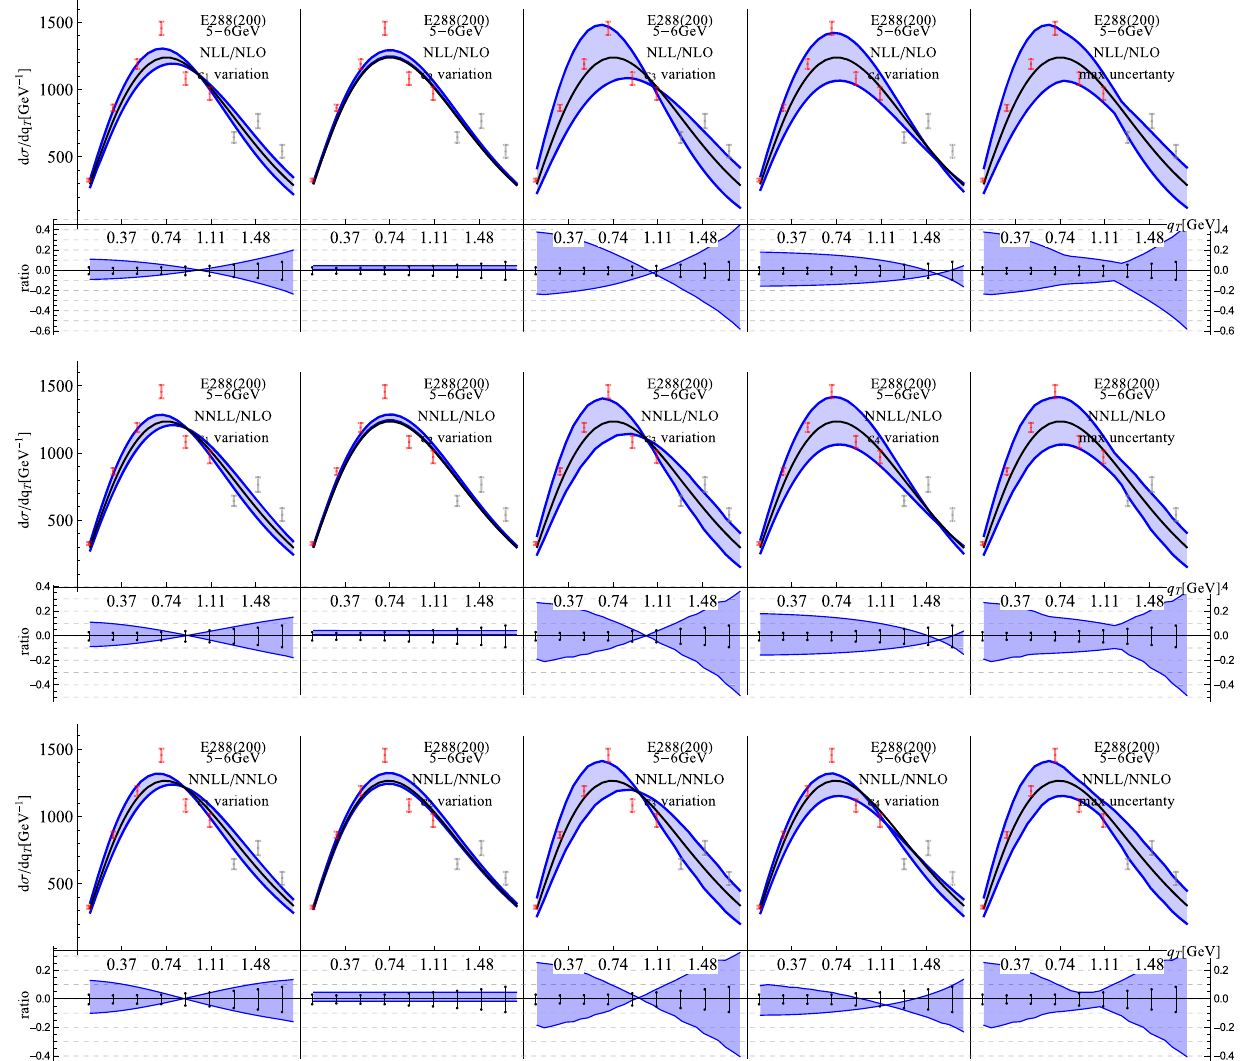
Fig. 6 Theoretical error-bands and experimental data points for E288 (200 GeV) experiment at 5–6 GeV. The theoretical error is estimated changing c 1 , 2 , 3 , 4 in the range ( 0 . 5 , 2 ) at each perturbative order. The